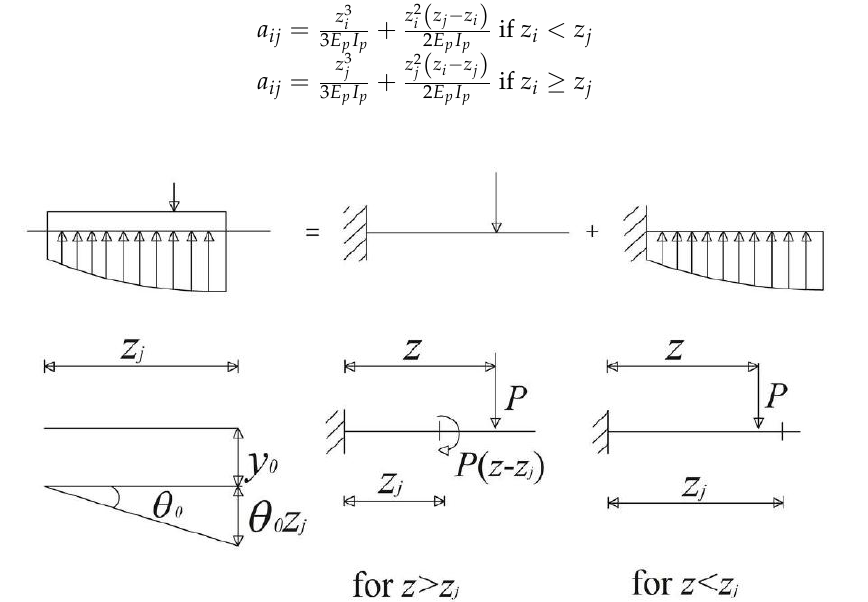
Figure 2. Pile flexibility matrix using the elastic beam theory (auxiliary restraint approach).